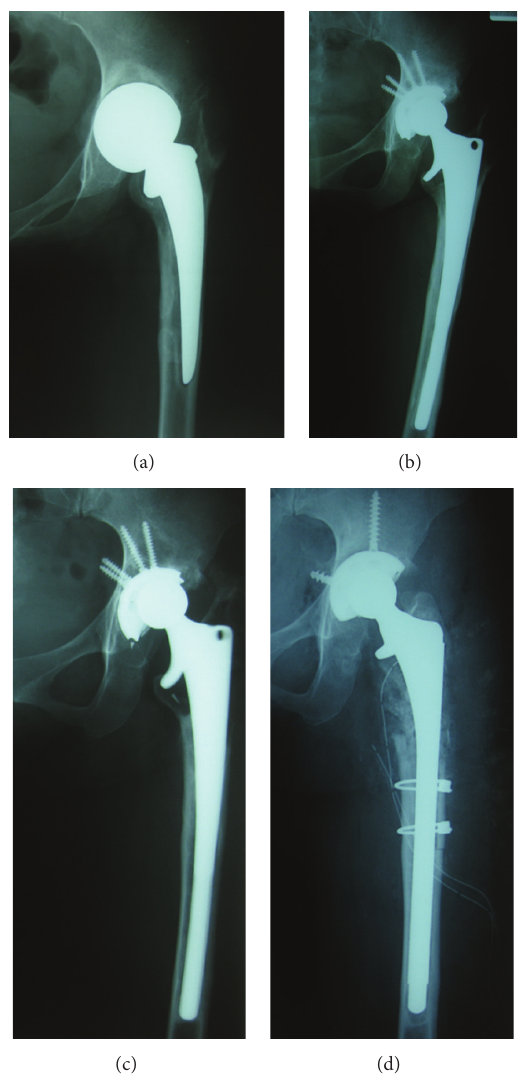
Figure 1: (a) Bipolar hemiarthroplasty (BHR) loosened aseptically and migrated superiorly. (b) Total hip arthroplasty (THA) was performed as a conversion from BHR to THA 22 years ago. Cup was unknown (Zimmer, Warsaw, IN, USA) and stem was BIAS long stem (Zimmer). (c) Stem prosthesis of primary THA loosened aseptically. (d) Revisional THA (cup, trilogy, stem, versis beaded full coat plus; inner head, 26 mm cobalt-chrome) (Zimmer) was performed because of aseptic loosening of THA 9 years